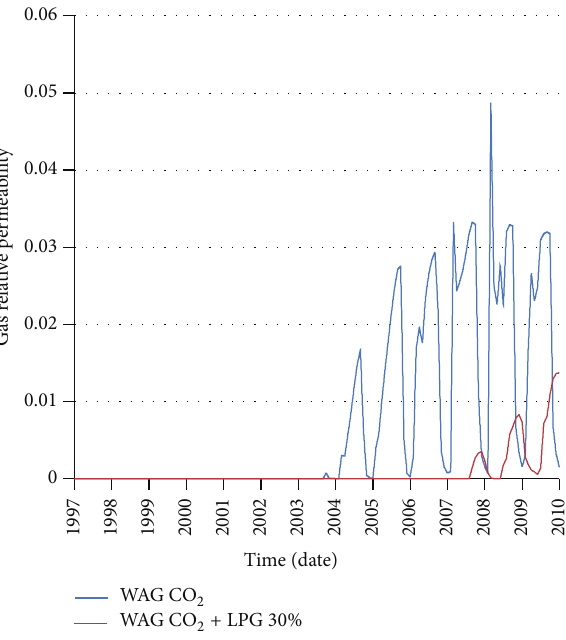
Figure 7: Gas saturation with LPG mole fraction of injection gas near production well for oil-wet condition.